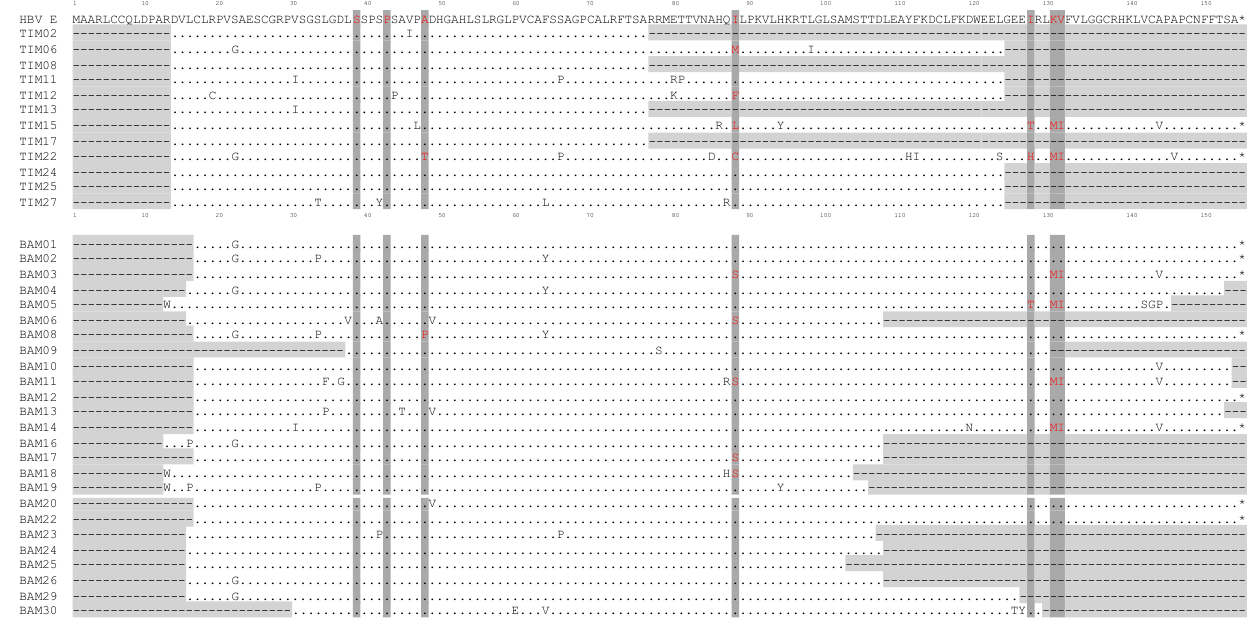
Figure 3. Comparison of HBV HBx protein sequences (154 aa) for 37 chronic carriers presenting with HBV genotype E in this study. HBV E refers to a consensus aa sequence obtained by comparison of 380 available non-duplicate sequences from the HBV database (https://hbvdb.lyon.inserm.fr/HBVdb/, accessed on 22 September 2020). The points indicate unchanged aa compared to the reference sequence. Areas shaded in light gray (dotted lines) indicate non-amplifiable regions. * indicates a stop codon. Areas shaded in dark grey (aa in red) show point mutation positions commonly associated with HCC in the literature. TIM, Timbuktu (Mali); BAM, Bamako (Mali).